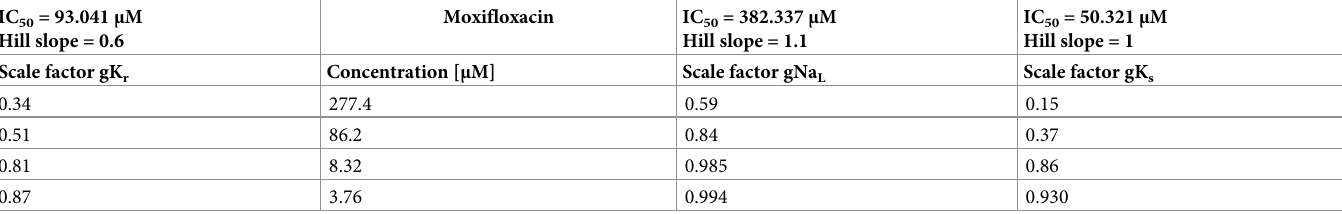
Table 3. Alternative scale factors used to simulate pharmacological manipulation with Moxifloxacin. IC 50 = 93.041 μ M Hill slope =